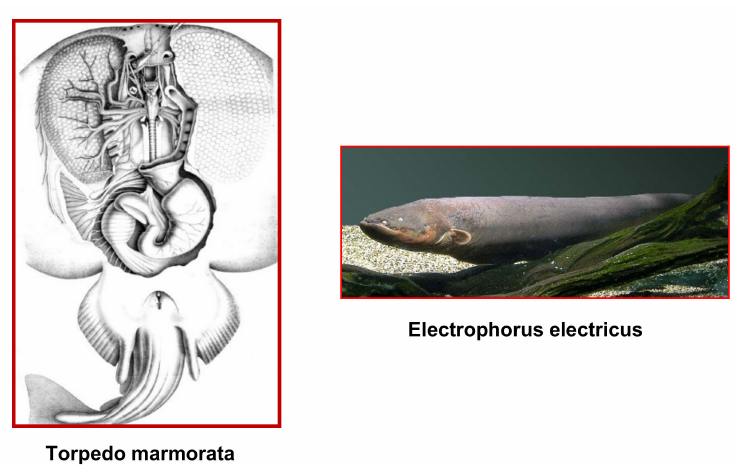
Figure 2. The electric fishes T. marmorata and E. electricus . In the left part of the figure the electric organs from T. marmorata have been uncovered by dissection.